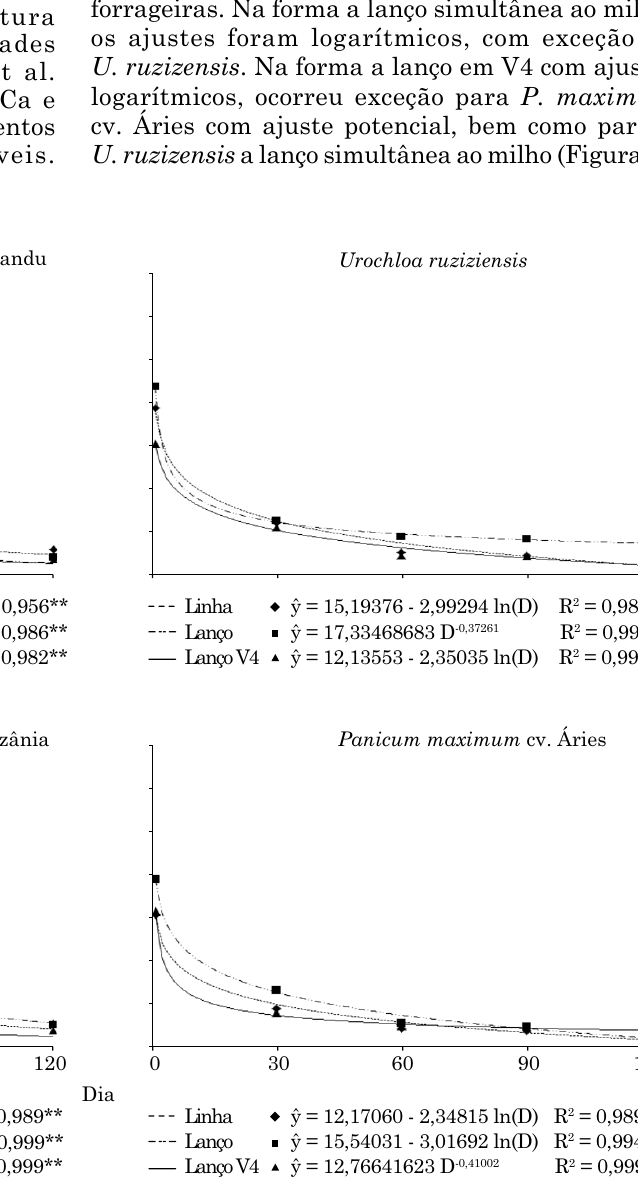
Figura 6. Magnésio residual na palhada das forrageiras remanescente no solo até 120 dias durante o cultivo da soja, para as condições das forrageiras semeadas no plantio do milho, na linha (Linha) ou a lanço (Lanço) ou no estádio V4 a lanço (LançoV4). **